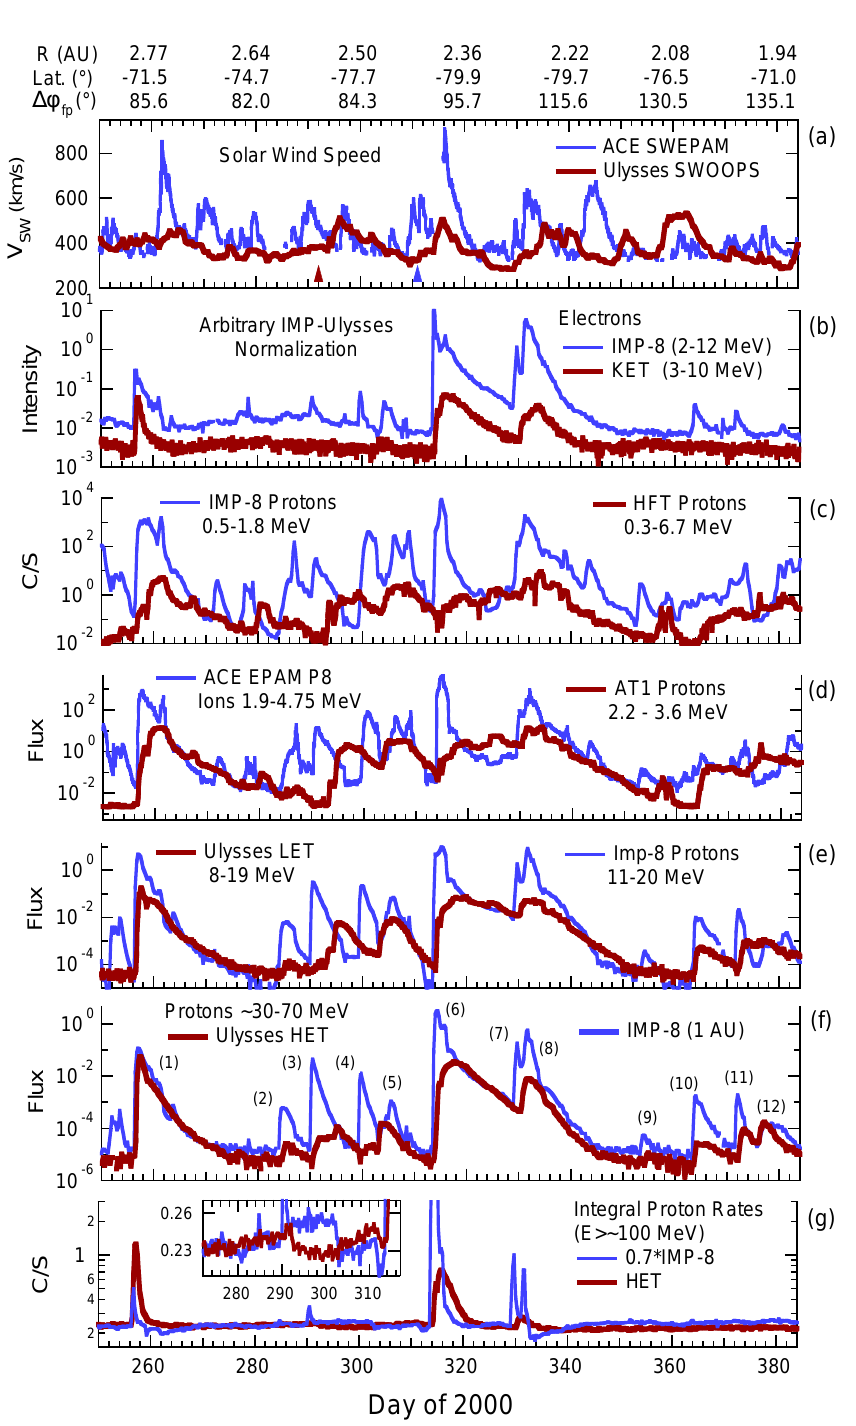
Fig. 3. (a) Solar wind speeds measured at IMP-8 and Ulysses during Ulysses passage over the Sun’s south polar regions in 2000–01 plotted vs. days from start of year 2000. To convert to day of year 2001 for days beyond 366 on the bottom (time) axis, subtract 366. Red and blue triangles in the bottom axis indicate times of the Forbush-like decreases observed in the IMP and Ulysses integral intensities shown in the inset in panel (g). Ulysses’ radius, latitude, and longitudinal separation of the footpoint of Ulysses 400 km/s Parker field line on the Sun from that of the field line through Earth are indicated above the top axis. (b)–(g) Intensities or fluxes of cosmic rays and solar energetic particles measured by channels covering nearly the complete range of energies measured by the COSPIN suite of instruments (red curves), together with simultaneous measurements at similar energies from IMP-8 or ACE near Earth (blue curves). For intensity or counts/second measurements, normalization between Earth and Ulysses channels is arbitrary. No normalization has been applied to flux measurements. The inset in Panel (g) is a blowup of integral intensities from day 272–317 with enhanced vertical scale to show the sequential Forbush-like decreases discussed in the text, first at Ulysses, then 10 days later at